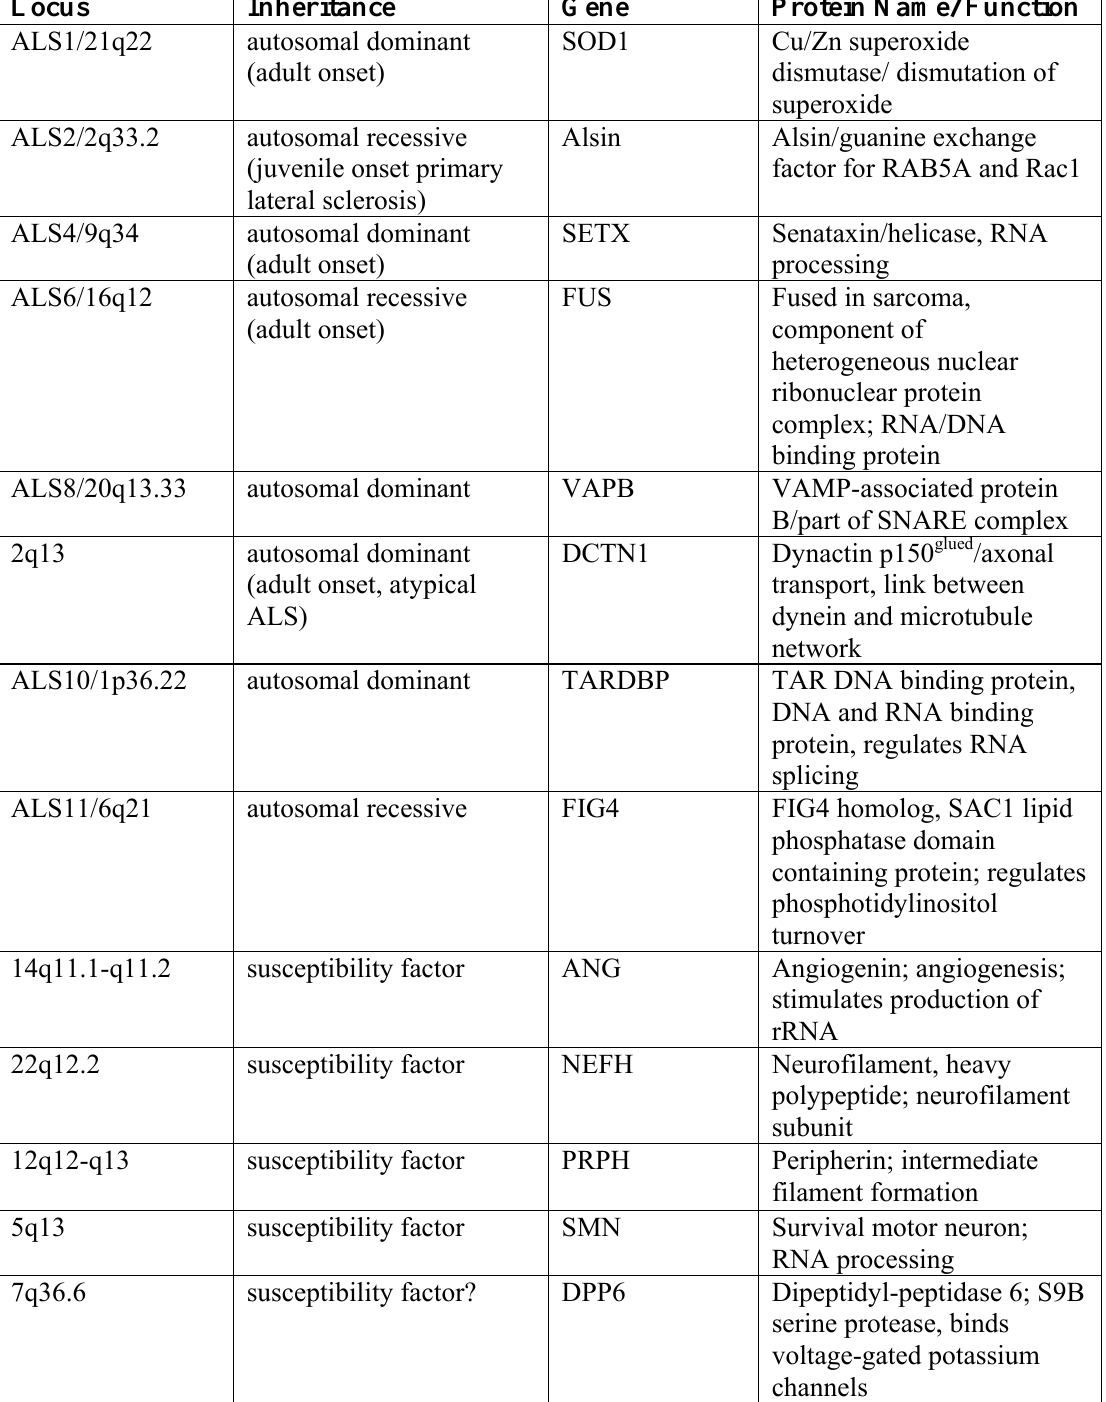
Table 4. Mutant/Polymorphic Genes Linked to Familial